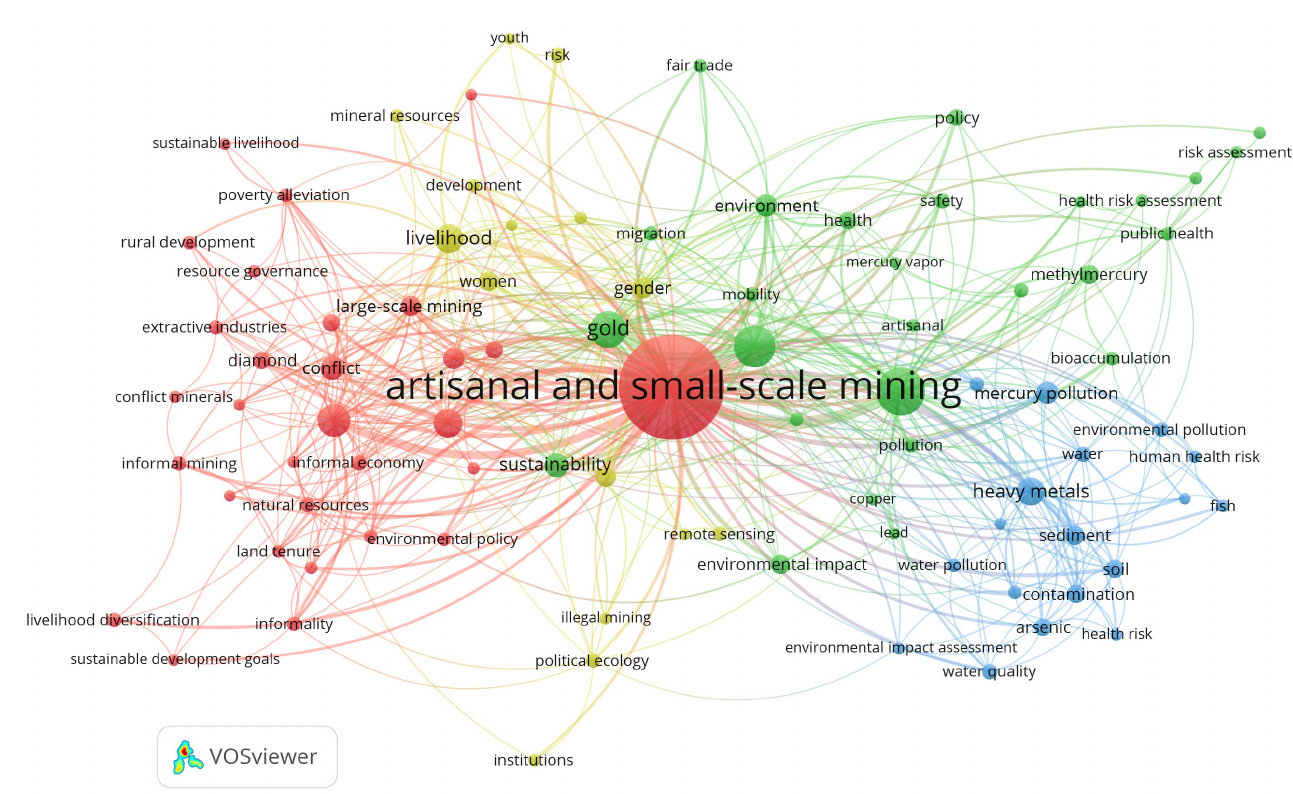
Figure 6. Author keyword co-occurrence bibliometric map in ASM.